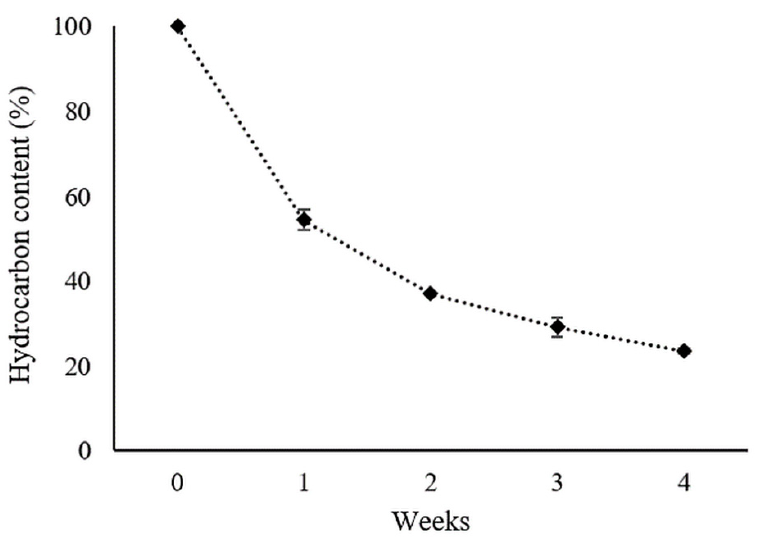
Figure 5. Degradation of hydrocarbons by the ZCR6 strain (mean ± SD, n D